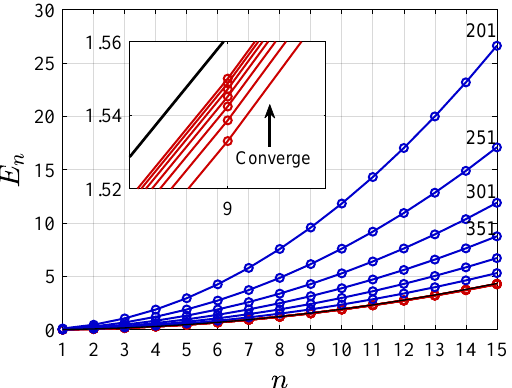
Figure 1. Eigenvalues of the kinetic energy operator { E n } n = 1,2,... as obtained by the standard FDM and by the present (variational) FDM. Red curves are obtained by the standard FDM for fixed value of L = 16 for growing number of grid points N such that ∆ X = 16/ N . The blue curves are obtained by the present (variational) FDM for a fixed small grid spacing δ x and increasing number of grid points. The kinetic energy matrix is calculated by using m = 3 (see Appendix A) and therefore is a tri-diagonal matrix. It is evident that the standard method provides lower bounds for the kinetic energy spectrum for every n ≥ 0 as N is increased ( N = 201, 251, . . .), whereas the present (variational) FDM, first presented here, provides upper bounds to the exact values. In this case, the standard FDM converges faster than the present FDM but it is not a variational